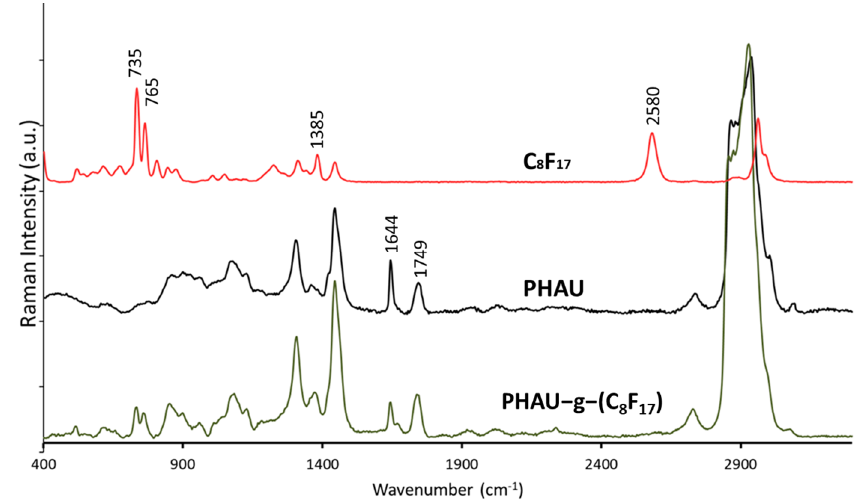
Figure 3. Raman spectra of C 8 F 17 , PHAU and PHAU-g-C 8 F 17 .